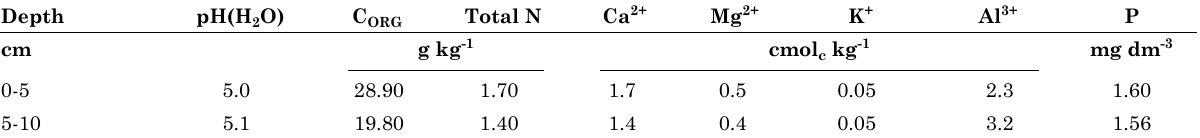
Table 1. Soil chemical characterization of a 15-year-old secondary forest in eastern Amazonia